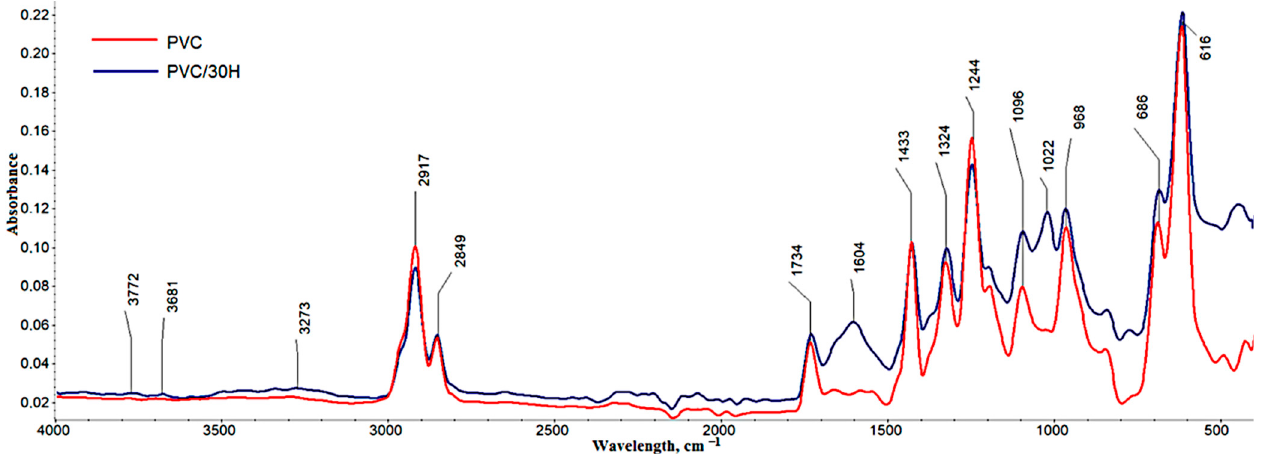
Figure 4. FTIR spectra for PVC and its composites with 30% wt. of residual hops.